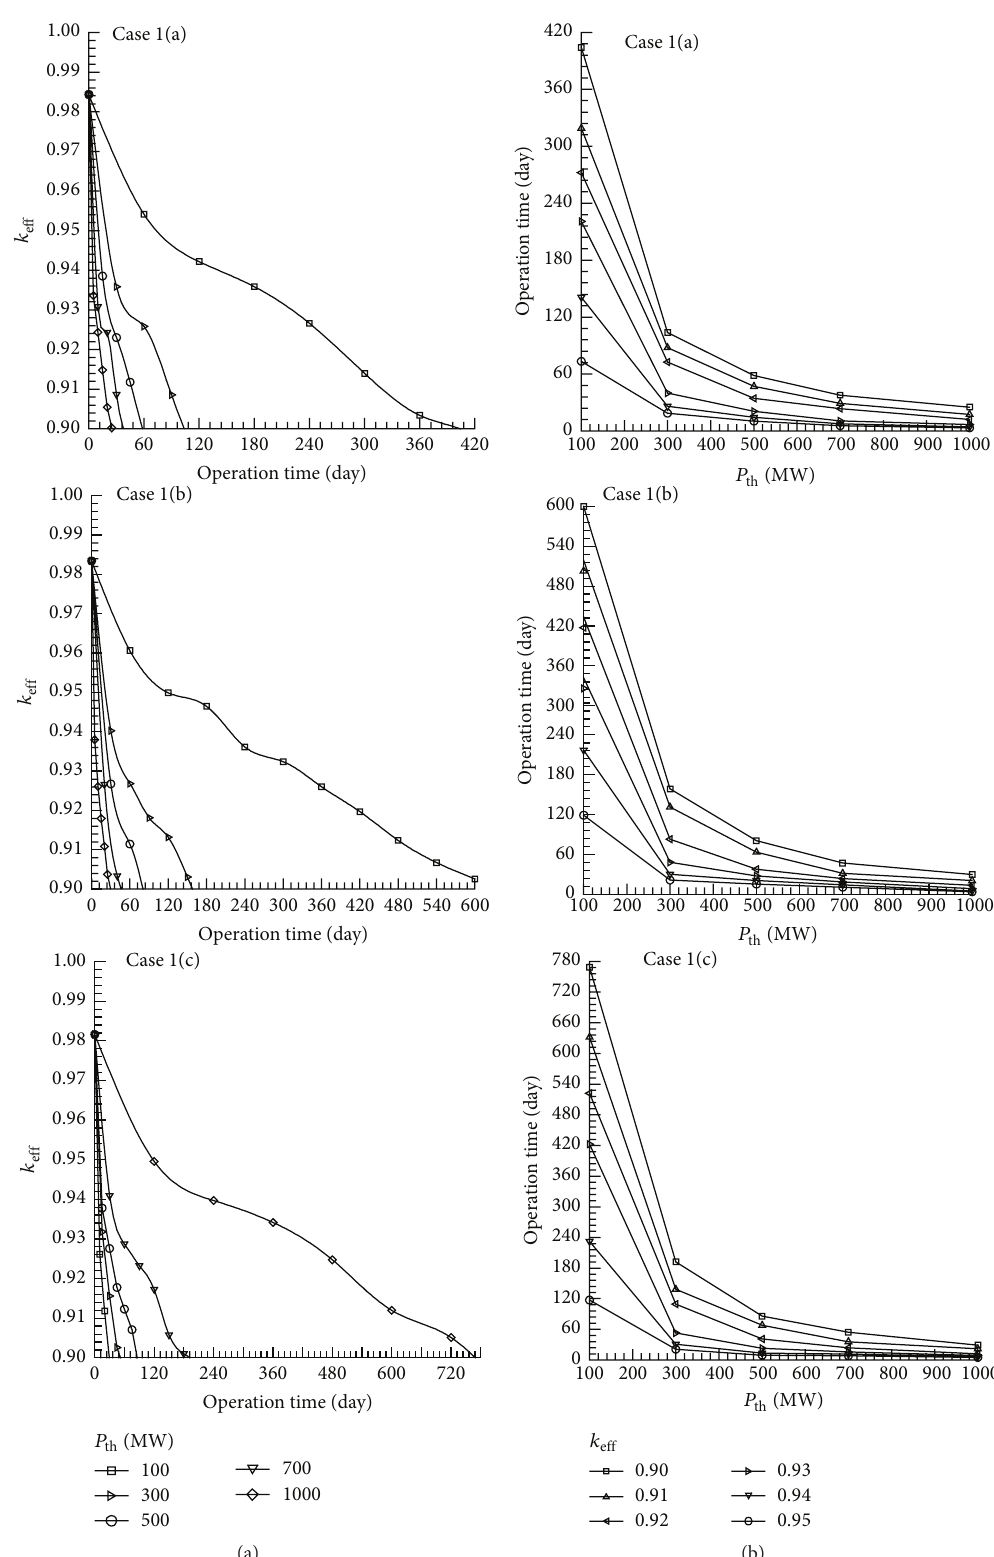
Figure 4: (a) Variations of the effective neutron multiplication in the various cases of thermal power depending on the operation time. (b) The operation time at which effective neutron multiplication reached various values (0.90–0.95) versus the thermal